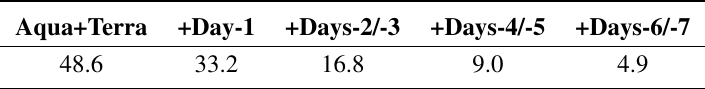
Table 2. Percentage of cloud coverage, averaged over the period 10 January 2004–10 December 2006, for the different improvement